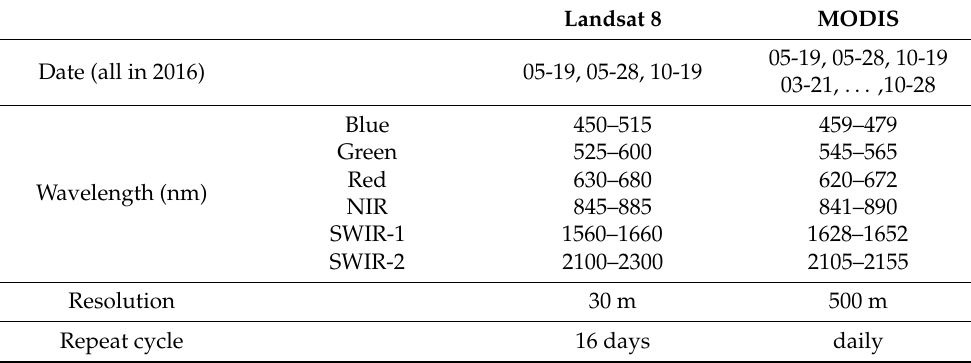
Figure 3. MCD43A4 images of the base date (May 19) and two predicted dates (May 28 and October 19). Table 1. Detailed information on remote sensing data used in this